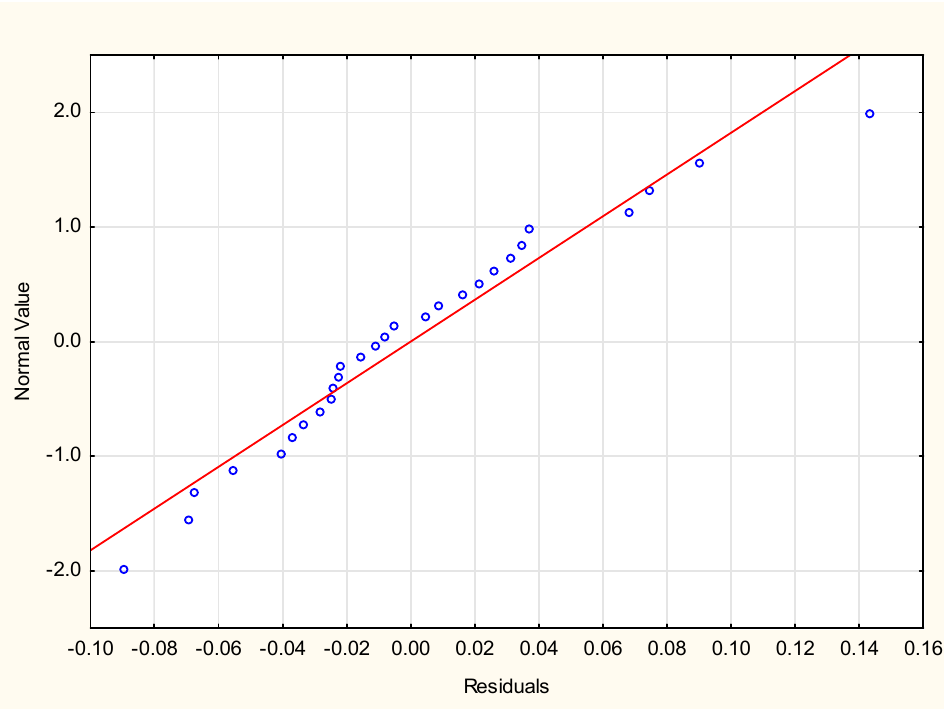
Figure 3. Residual’s normality plot. Source: authors’ calculations results.